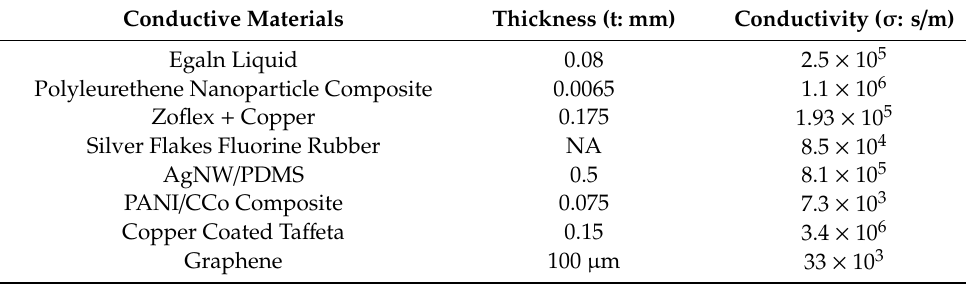
Table 2. Flexible conductors